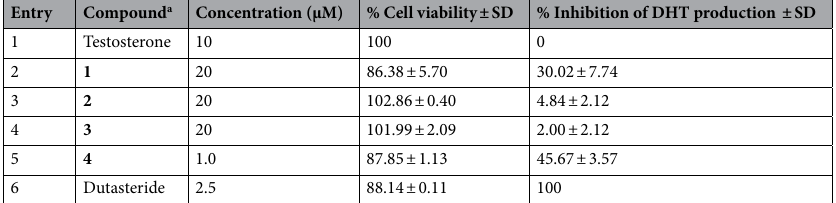
Table 1. Preliminary screening of SRD5A1 inhibitory activity of caffeic acid and its amide derivatives using the HaCaT cell-based assay with HPTLC. a Testosterone is an enzyme substrate. Compound 1 is caffeic acid. Compounds 2−4 are caffeic acid amide derivatives. Dutasteride is a steroid 5α-reductase inhibitor, which was used as a positive